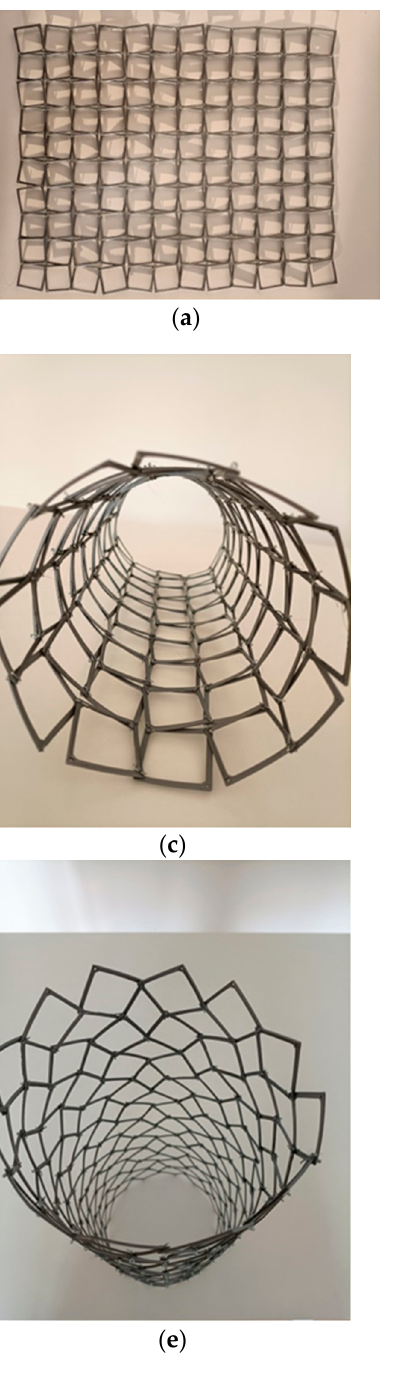
Figure 14. Expanded planar structure ( a , b ) of 12 × 10 square hard polymer frames and tubular structure ( c – f ) after joining in closed and open positions.